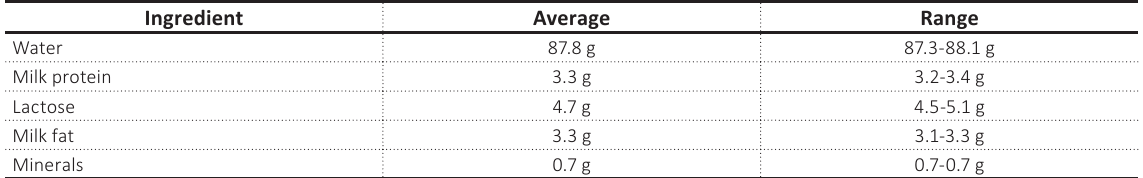
Table A1. Composition of cow’s milk (per 100 g of cow’s milk)